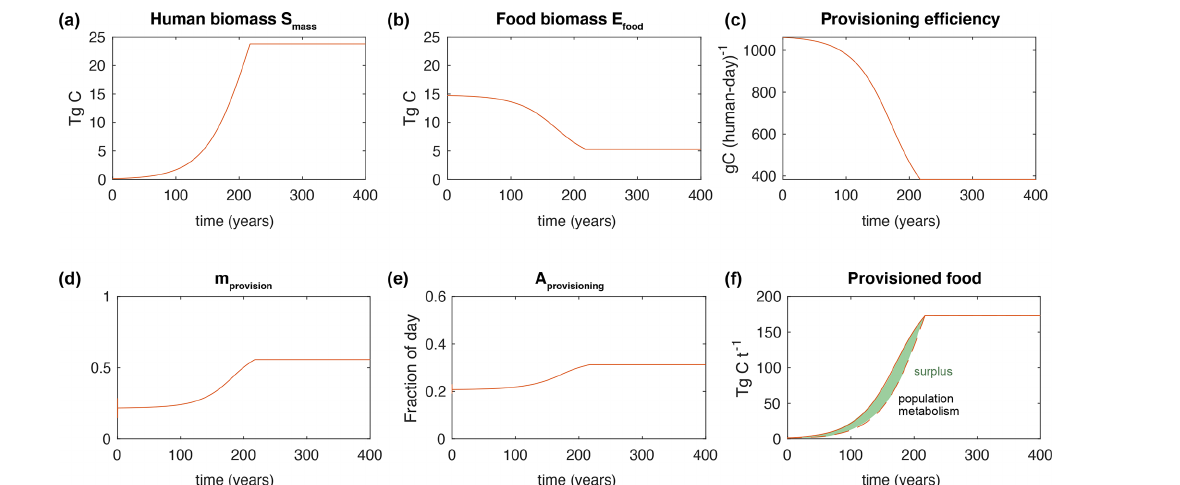
Figure 5. Time series of a typical model experiment. In (f) , the dashed line indicates the metabolic cost of maintaining the population (i.e. ω human S mass ) and the shaded green area represents the food